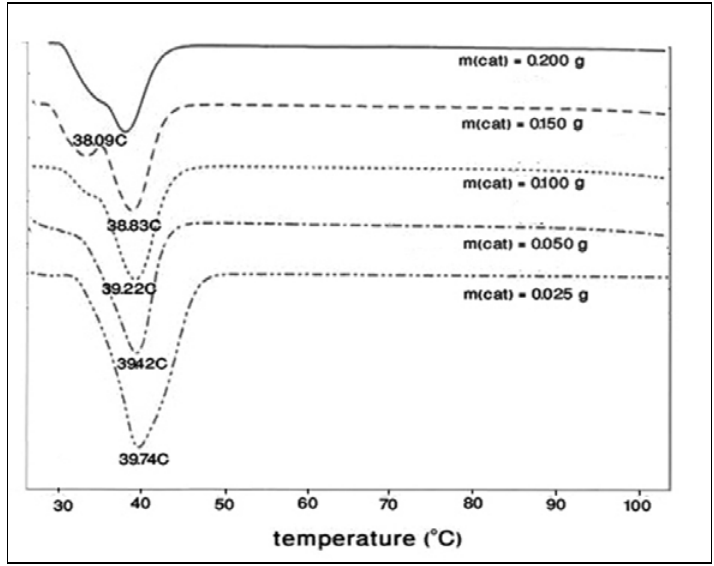
Figure 6. Effect the amount of the catalyst on the T conditions: T = 20 ºC; AA/THF (volume ratio) =